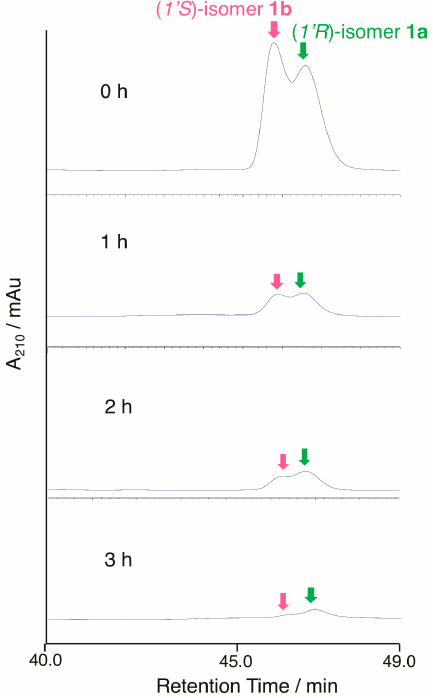
Figure 6. Substrate recognition of the C-1’ stereochemistry by SrrO. Conversion efficiency of a mixture of (1’ R )-isomer 1a and (1’ S )-isomer 1b was analyzed by chiral HPLC. Chromatogram was monitored by UV absorbance at 210 nm.